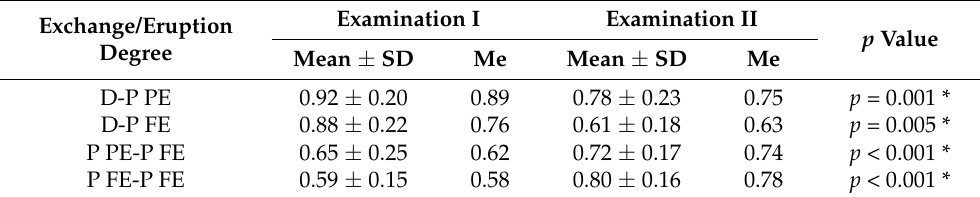
Table 2. Thickness of the attached gingiva (GT)